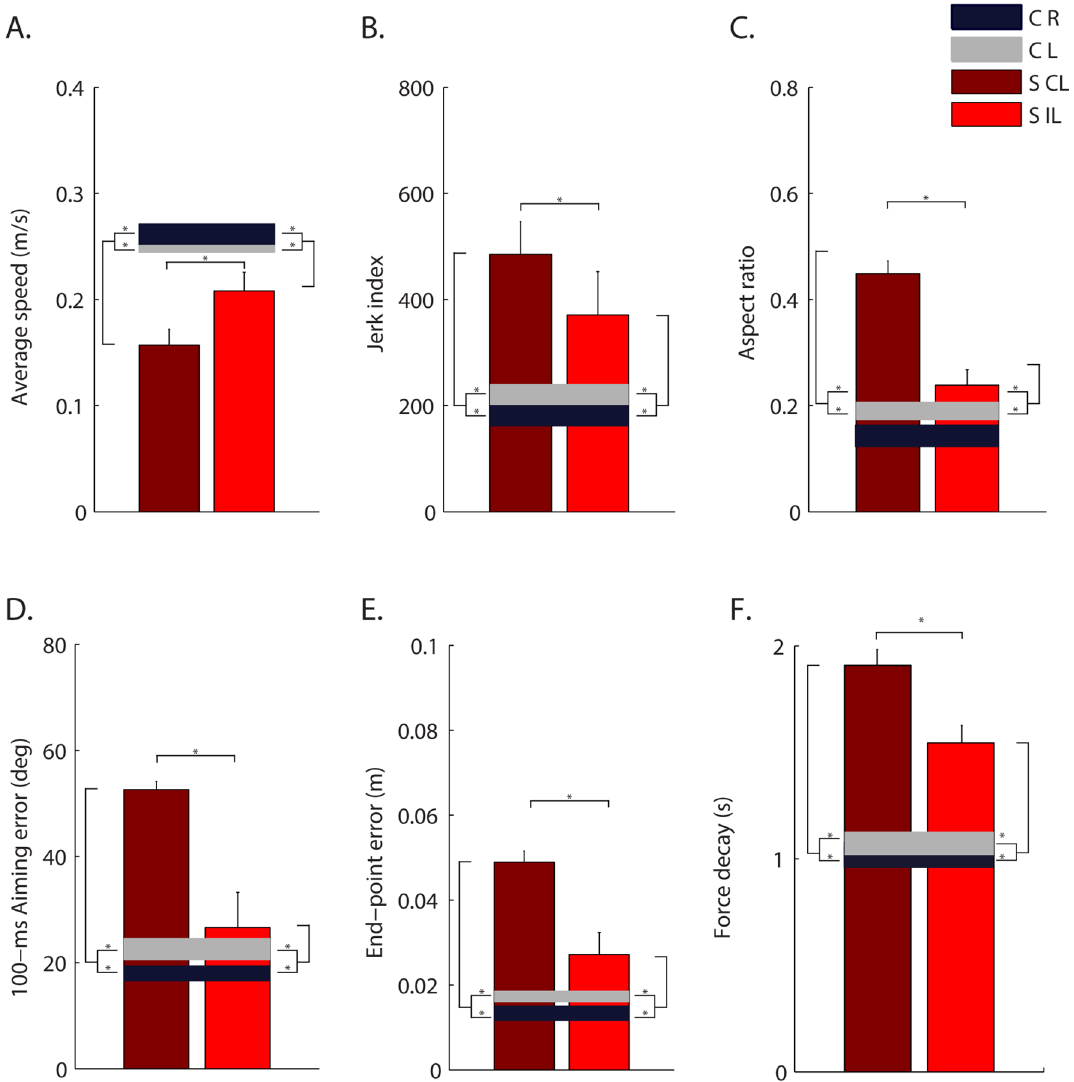
Figure 2. Features of the isometric force applied by the subjects to control the cursor trajectories (1.4 cm = 1 N). Control subjects (C) and stroke subjects (S) are shown with different colors as indicated in the legend. Darker and brighter colors represent the right (R) and left (L) arm respectively in the control subjects, and contralesional (CL) and ipsilesional (IL) arm in the stroke subjects. The error bars indicate the standard error of the indicators. * indicates significant differences (p < 0.05). The indicators ( A – E ) are related to the center-out movements not including the holding time. Indicator F is related to the force release phase. ( B , C ) The indicators jerk index and aspect ratio are